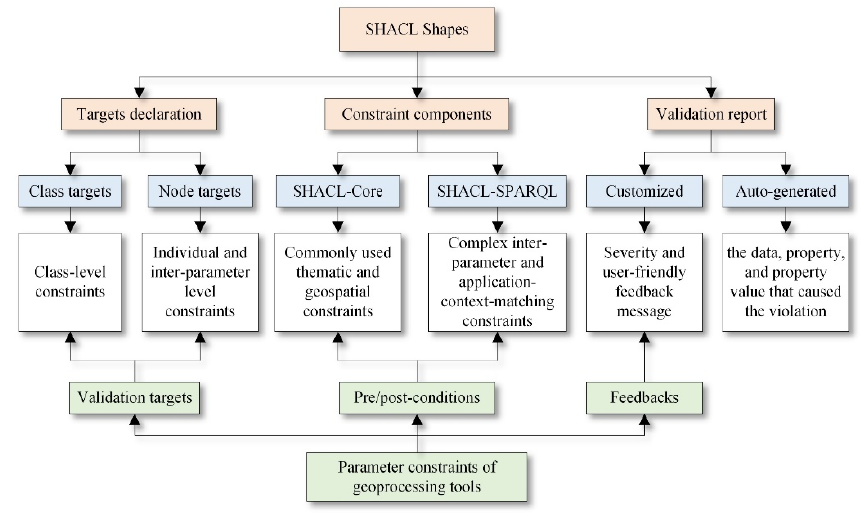
Figure 3. SHACL features and their match to parameter constraints.